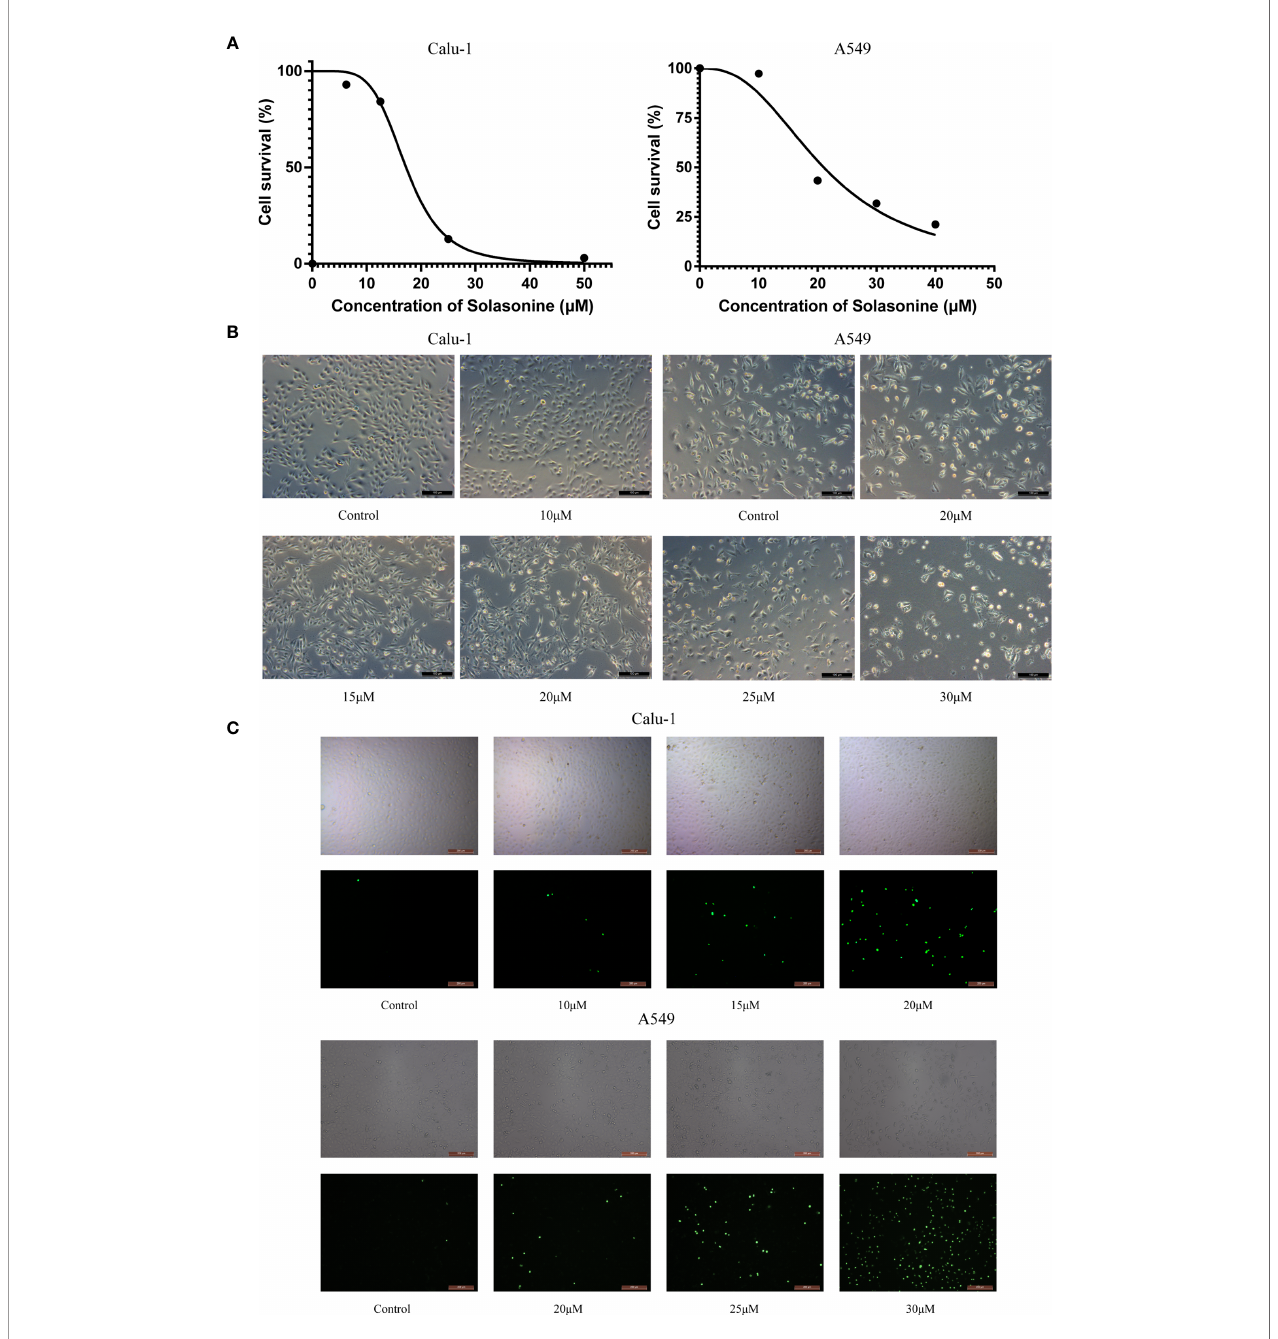
FIGURE 1 | The cytotoxicity of solasonine in LUAD cells. (A) The cell viability of Calu-1 and A549 cells was measured using the CCK-8 assay after SS treatment for 24 h. (B) Microscope observation of Calu-1 or A549 cells treated with 10, 15, 20 m M or 20, 25, 30 m M of SS for 24 h, respectively. Scale bars: 100 m m. (C) Cells were exposed to different concentrations of SS and 100 nM of SYTOX Green for 24 h. The signal was captured and examined through the FITC channel of fl uorescence microscopy. Scale bars: 200 m